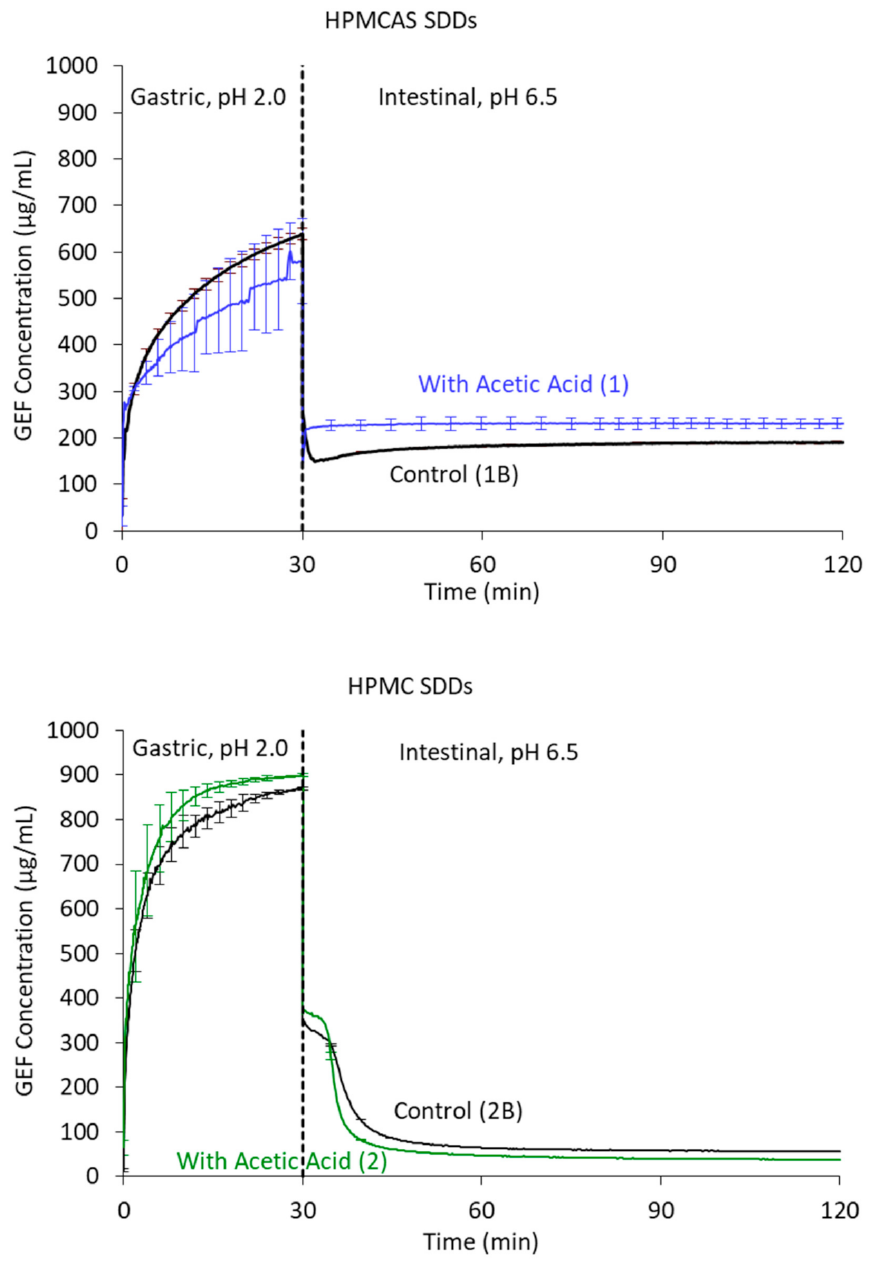
Figure 6. In vitro gastric-to-intestinal transfer dissolution tests for the HPMCAS ( top ) and HPMC ( bottom ) SDDs sprayed from THF:H 2 O (control) and from MeOH:H 2 O with acetic acid as a processing